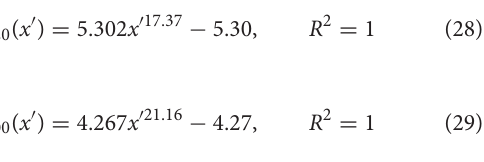
1 to the 0.01 spectral deviation. The final fitting equations for the stimuli at 120, 300, and 720 Hz are,